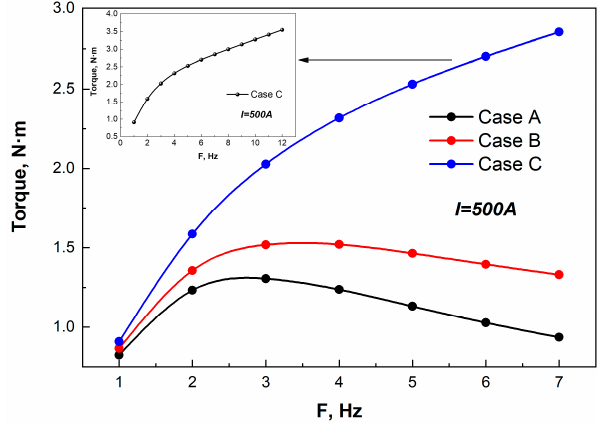
Figure 16. Relationship between the electromagnetic torque of strand and the current frequency under different stirrer installation positions.